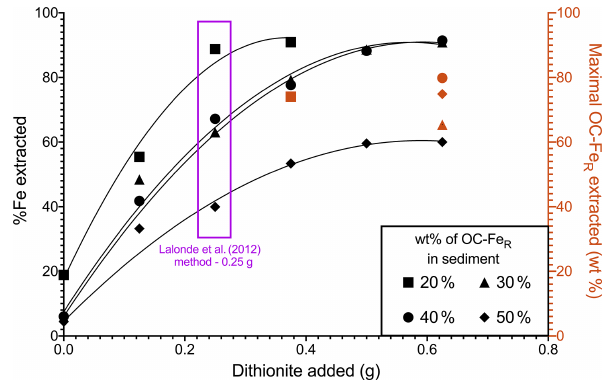
Figure 1. Reduction capacity of Na dithionite in the extraction es- timated from %Fe extracted with varying Na dithionite additions across an OC–Fe R concentration gradient. Red shapes indicate the amount of OC–Fe R extracted for the concentration of Na dithionite at which Fe is maximally extracted for that sample (black). Com- pound maximal instrument error is minimal and can be found in the data